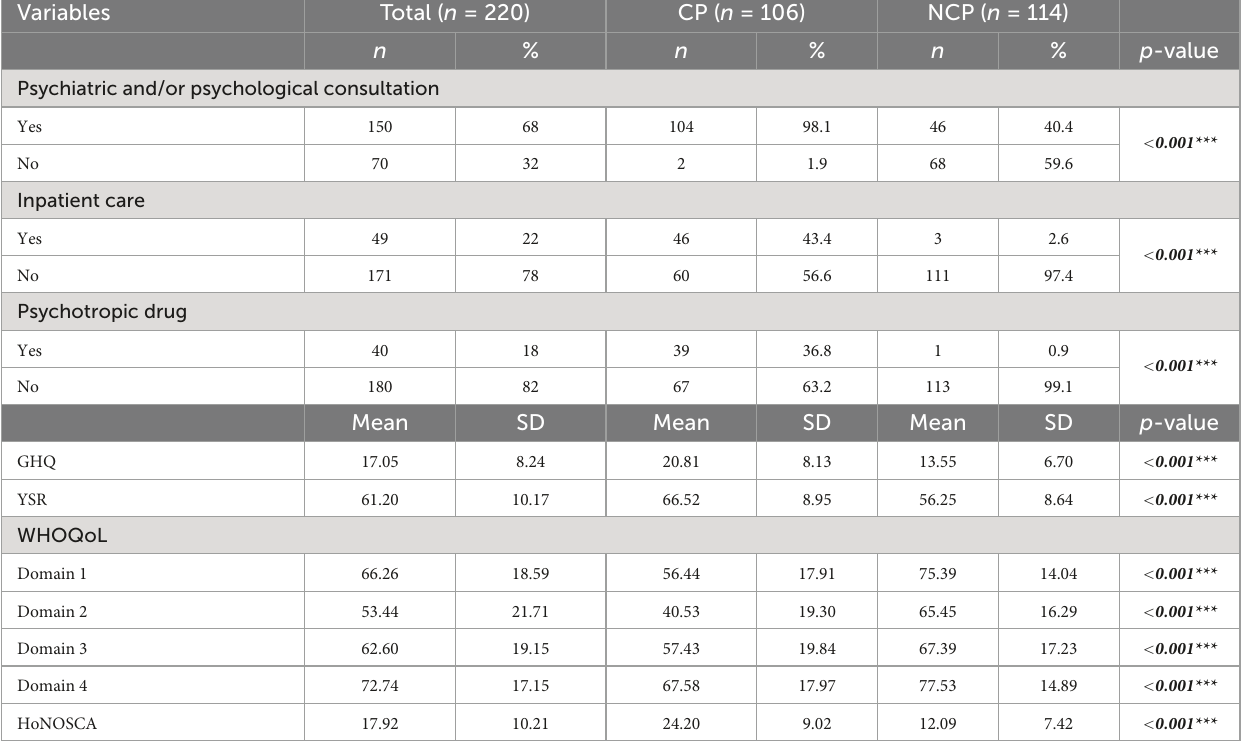
TABLE 2 Comparison of clinical data by groups ( N =